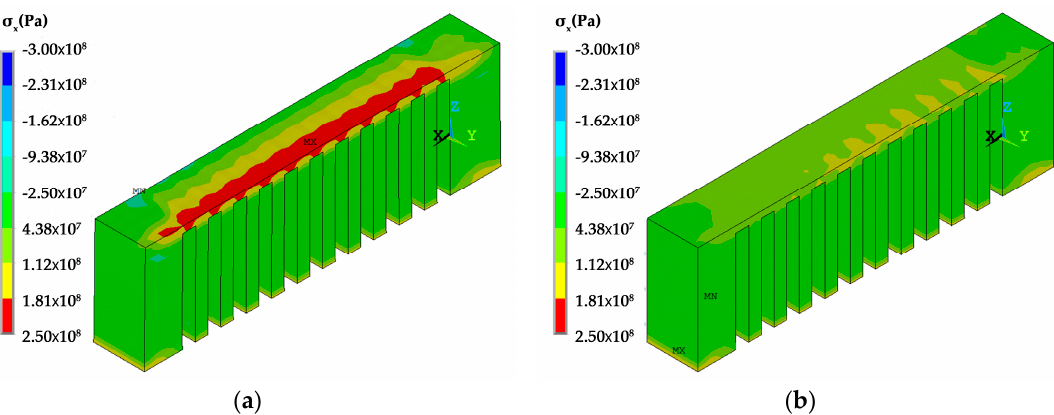
Figure 9. Residual stress σ x distribution of the specimens under different scanning strategies at the end of laser scanning: ( a ) the x scanning route; and, ( b ) the y scanning route.